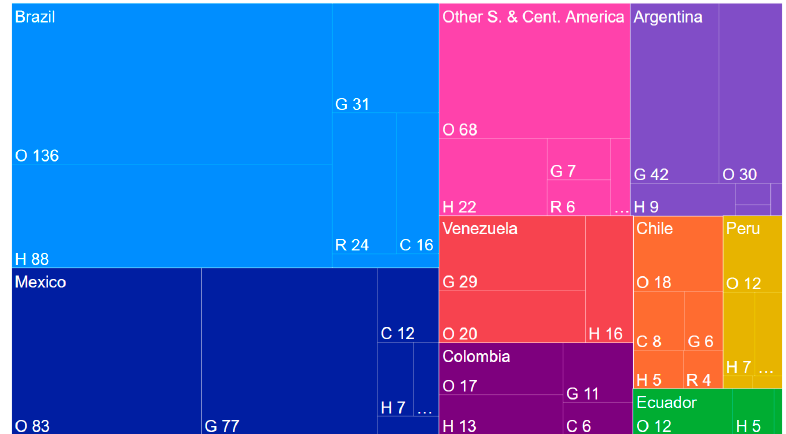
Figure 2. Energy consumption by country in Latin America in million tonnes of oil equivalent. One tonne of oil equivalent is the amount of energy released when one tonne of crude oil is burned and is equal to 11.6 Mwh, showing that Brazil and Mexico are the main energy consumers of the region. (“Other South and Central America” includes the remaining countries in Latin America). O = oil, G = natural gas, C = coal, N = nuclear, H = hydroelectricity, R = renewable. Source: World Bank, 2016 [23].